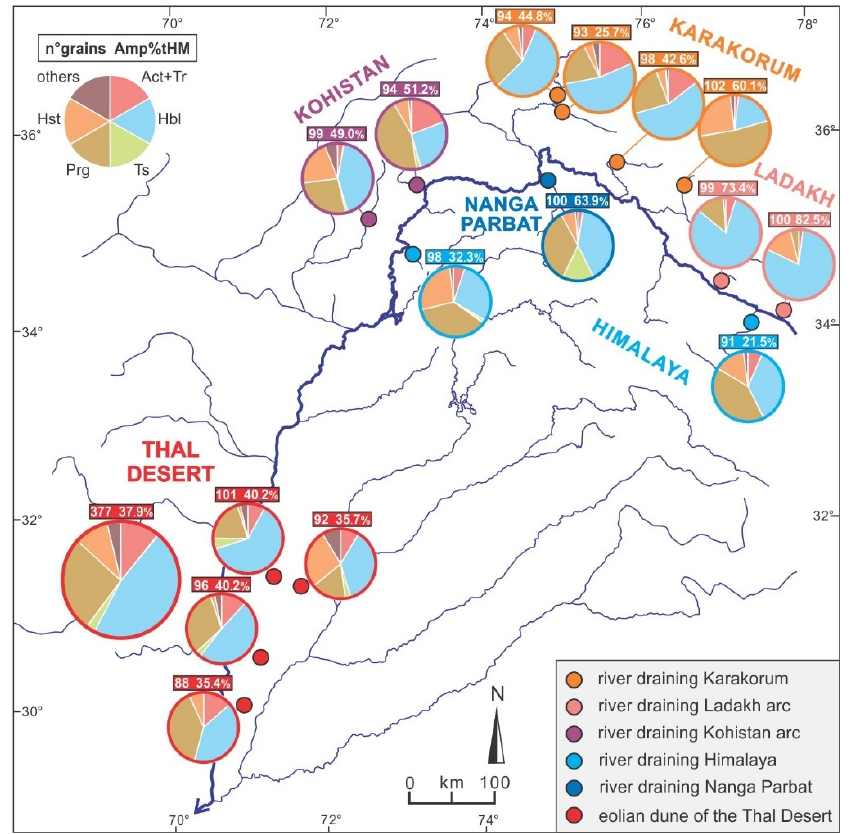
Figure 8. Calculated proportions of different varieties of detrital amphibole found in river and eolian sands of northern Pakistan. Act: actinolite; Hbl: hornblende; Hst: hastingsite; Prg: pargasite; Tr: tremolite; Ts: tschermakite.